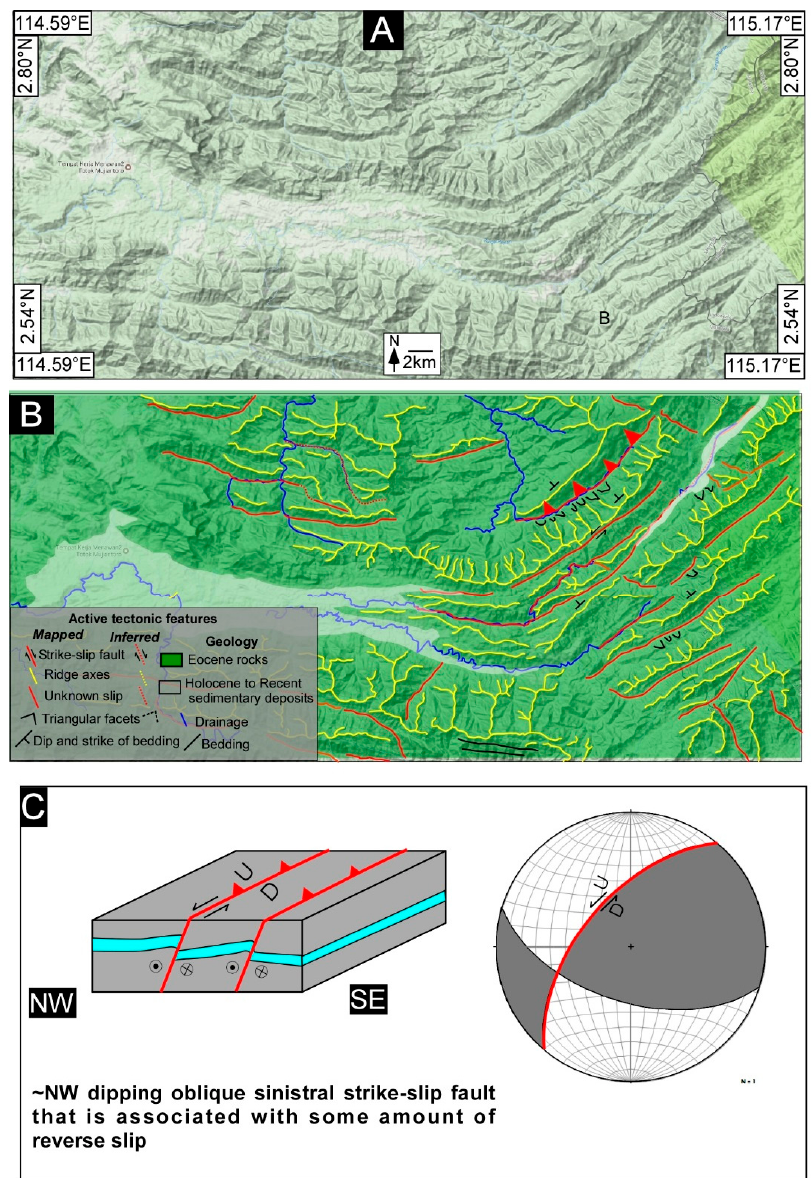
Figure 8. ( A ) Un-interpreted Google terrain image. ( B ) Shows evidence of ~NW dipping thrust faults, and strike-slip faulting. The prominently developed triangular facts have carved rock beds that ~dip NW, and only ~NW dipping beds are clearly visible. ( C ) Cartoon shows the possible nature of faulting where sinistral faults have a component of reverse slip. Also shown are the expected earthquakes on these faults.